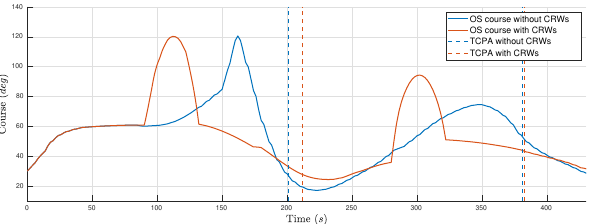
Figure 17: Simulation 1: Course profile for OS trajec- tory with and without